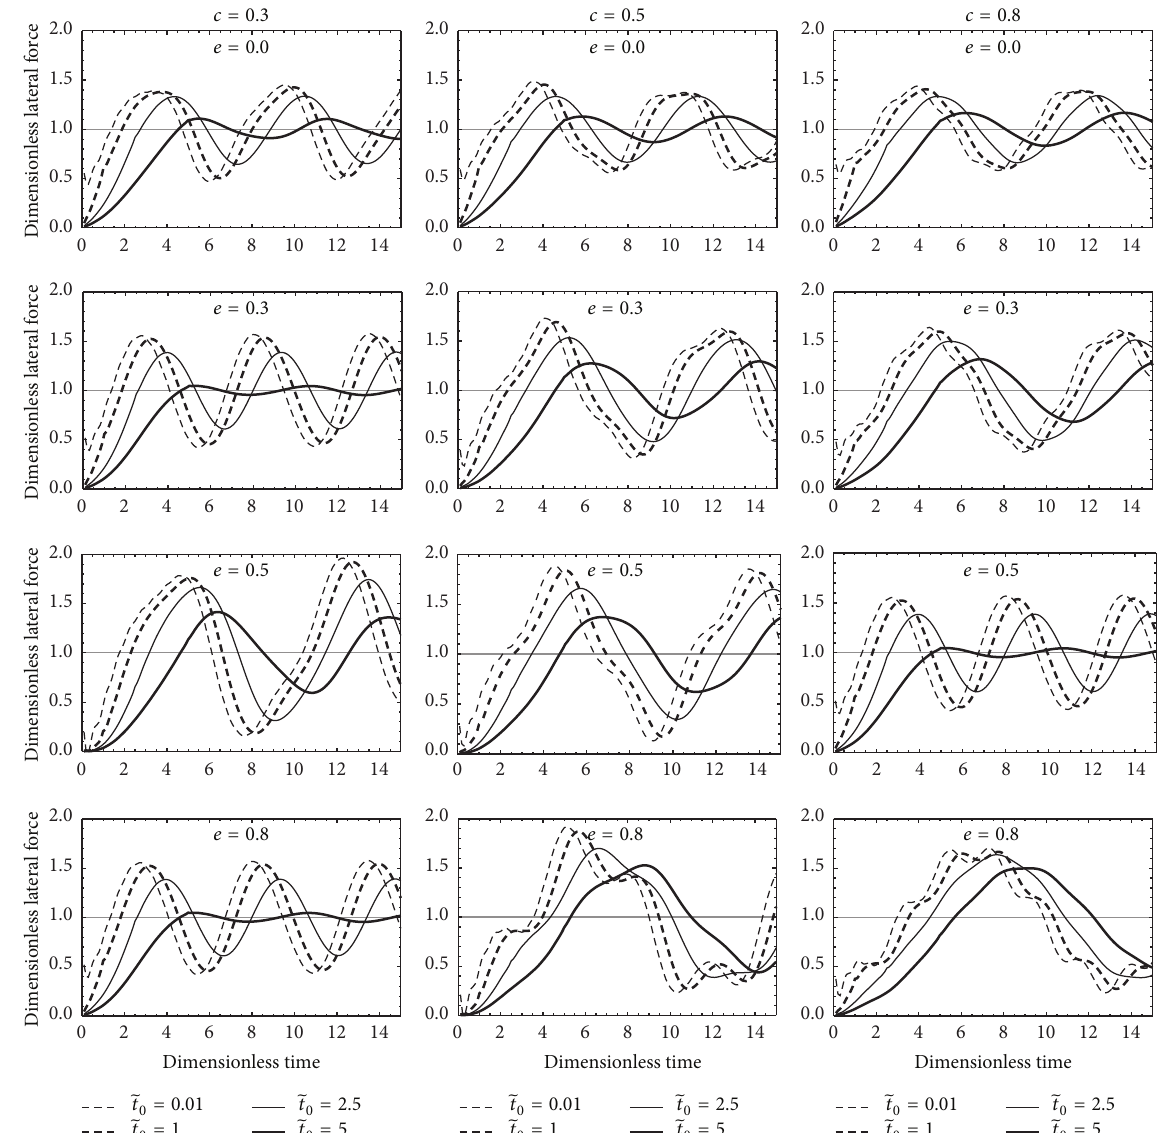
Figure 5: The lateral forces oscillation around the equilibrium point under oscillatory